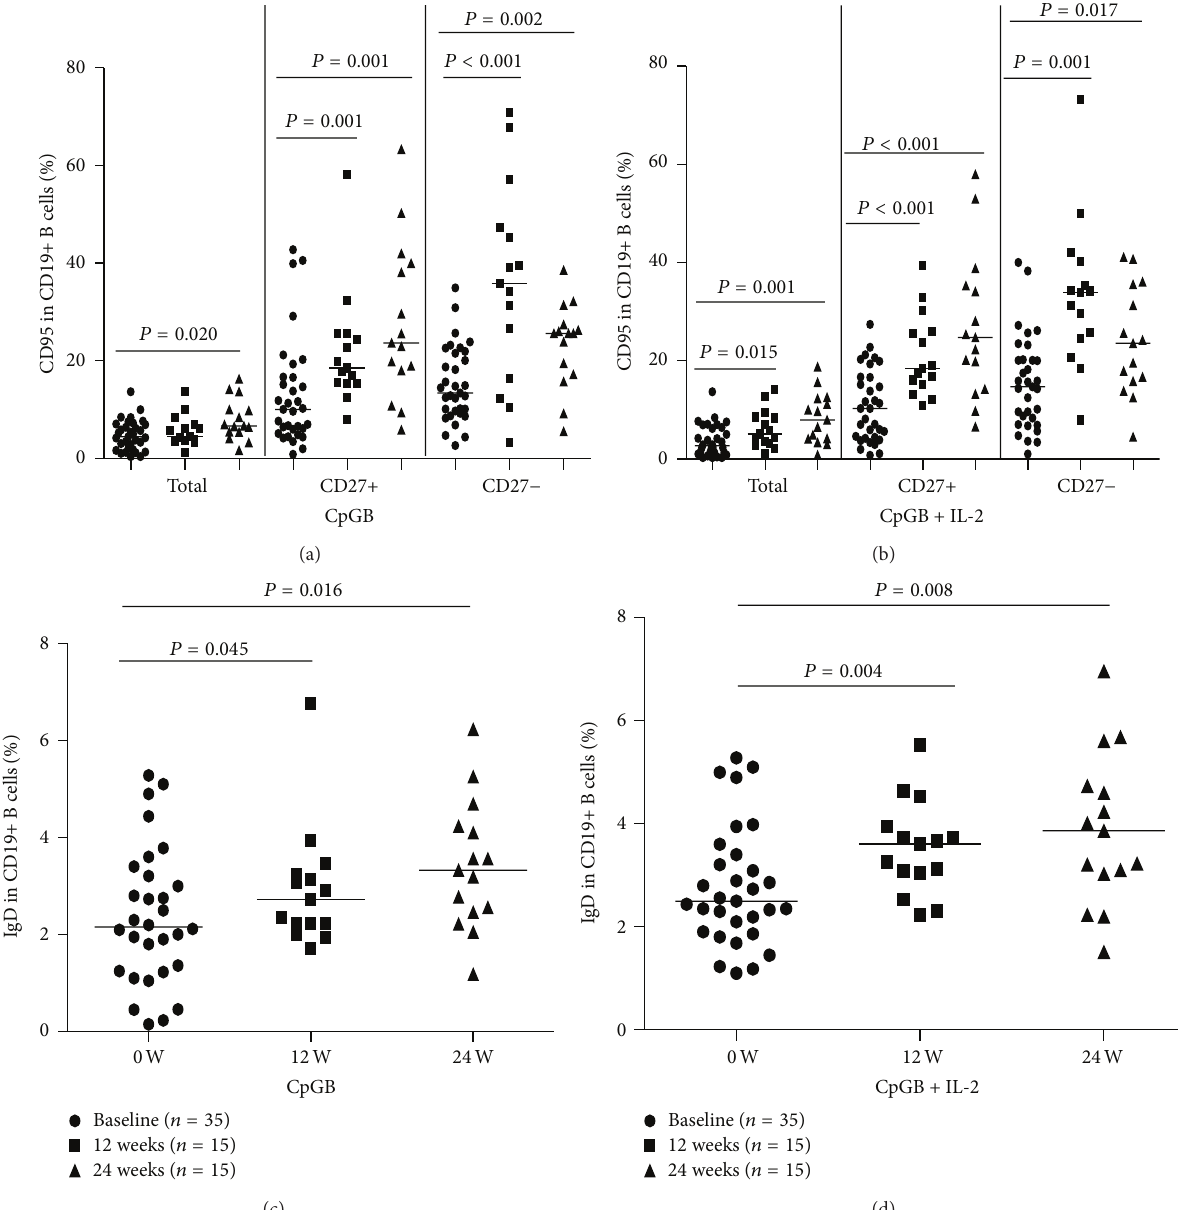
Figure 4: Treatment with adefovir dipivoxil modulates the frequency of CD95+ B cells in HBV patients. A total of 15 HBV patients were treated with adefovir dipivoxil for 24 weeks, and the frequency of CD95+ B cells and IgD+ B cells in peripheral blood was determined by flow cytometry analysis at baseline and after treatment at 12 and 24 weeks: (a) the expression of the exhaustion marker (CD95) on total (CD19+), memory (CD19+CD27+), and naive (CD19+CD27 − ) B cells stimulated with CpGB, (b) the expression of the exhaustion marker (CD95) on total (CD19+), memory (CD19+CD27+), and naive (CD19+CD27 − ) B cells stimulated with CpGB+IL-2, (c) the frequency of IgD on total (CD19+) B cells stimulated with CpGB, and (d) the frequency of IgD on total (CD19+) B cells stimulated with CpGB+IL-2. Data were analyzed by the Wilcoxon rank-sum test. The horizontal lines indicate the median values of different groups. Data are expressed as mean % of individual samples from at least two separate